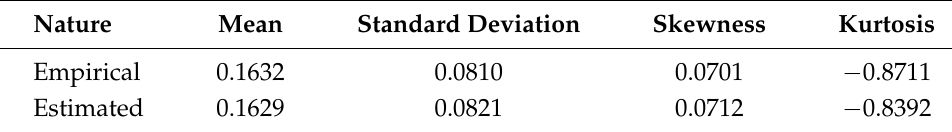
Table 6. Descriptive versus estimated statistics results for the drilling machine